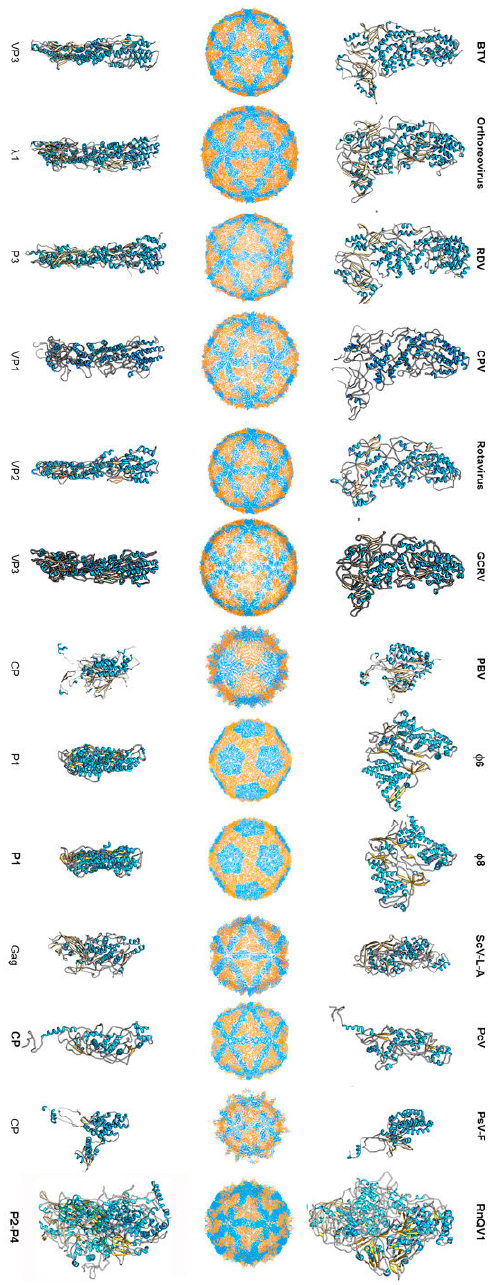
Figure 1. T = 1 capsid protein X-ray- and cryo-EM-based structures. Top row: T = 1 capsids of bluetongue virus (BTV), orthoreovirus, rice dwarf virus (RDV), cytoplasmic polyhedrosis virus (CPV), rotavirus, grass carp reovirus (GCRV), picobirnavirus (PBV), φ 6 phage and φ 8 phage, L-A virus of Saccharomyces cerevisiae (ScV-L-A), Penicillium chrysogenum virus (PcV), Penicillium stoloniferum virus F (PsV-F), and Rosellinia necatrix quadrivirus 1 (RnQV1), viewed along a two-fold axis of icosahedral symmetry (center row). BTV VP3 [2] (PDB accession number 2btv; 901 residues), λ 1 [41] (1ej6; 1275 residues), P3 [42] (1uf2; 1019 residues), VP1 [19] (3cnf; 1333 residues), VP2 [43] (3kz4; 880 residues), GCRV VP3 [22] (3k1q; 1027 residues), PBV CP [23] (2vf1; 590 residues), φ 6 P1 [44] (4btq; 769 residues) and φ 8 P1 [45] (4btp; 792 residues), Gag [26] (1m1c; 680 residues), PcV CP domain A [46] (3j3i; 498 residues; complete CP 982 residues), PsV-F CP [29] (3es5; 420 residues) and RnQV1-W1118 P2 and P4 [36] (5nd1; 972 and 1005 residues, respectively), shown from top view. Bottom row: side views of the same structures (T = 1 shell exterior at